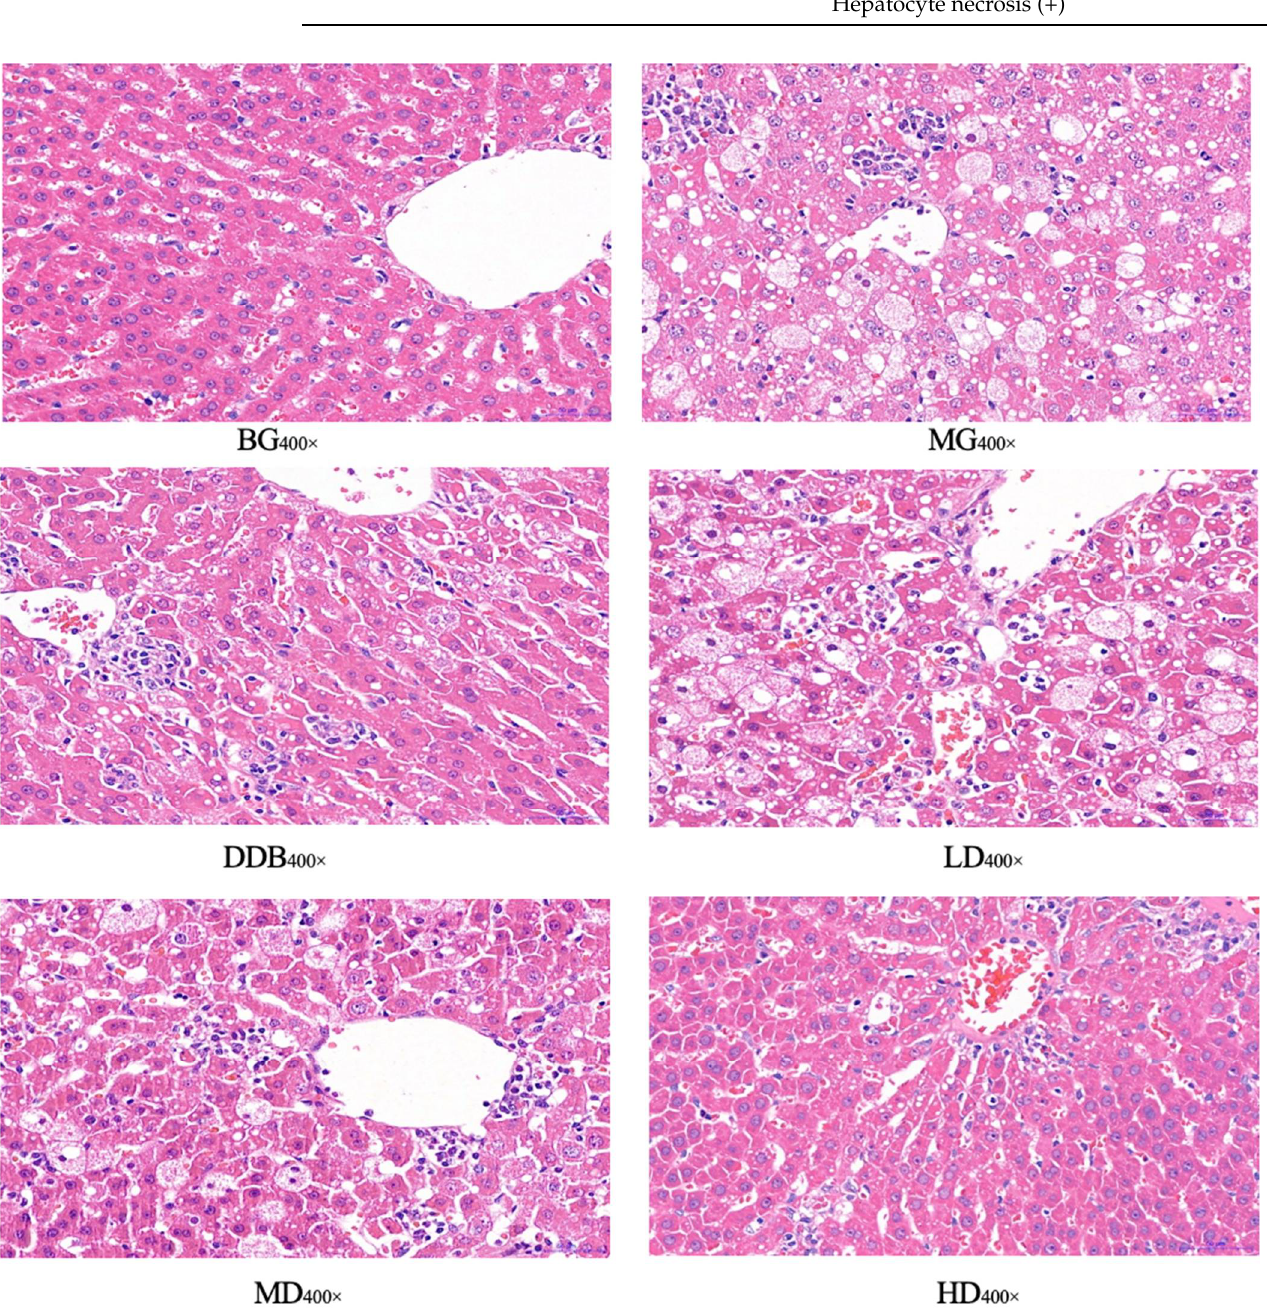
Figure 6. Light microscopic observation. Observations from light microscopy demonstrated that the degree of pathological change in the MG group was significantly aggravated compared to the BG group.